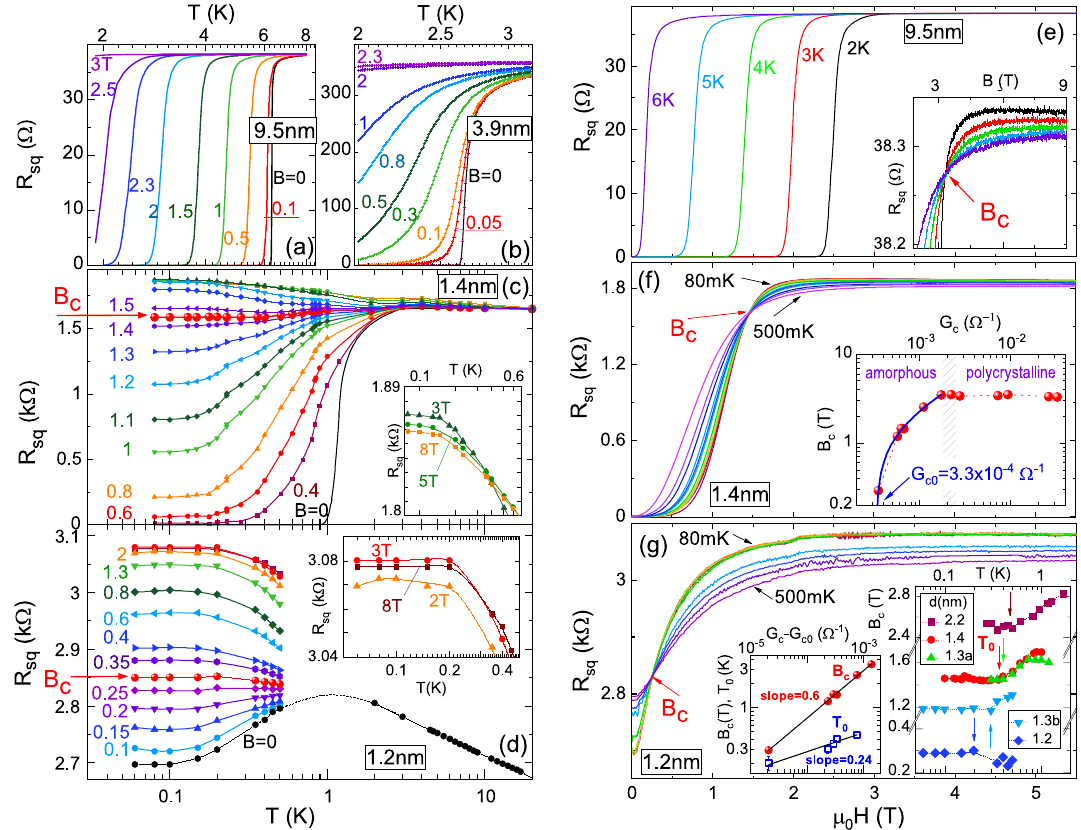
Figure 1. R sq versus T for various B as labeled near the curves (in teslas) ( a – d ), and R sq versus B at various T as labeled near the curves ( e – g ), for films with various d : ( a ) 9.5 nm, ( b ) 3.9 nm, ( c ) 1.4 nm, ( d ) 1.2 nm, ( e ) 9.5 nm, ( f ) 1.4 nm, ( g ) 1.2 nm. Red arrows indicate B c . Insets in ( c ) and ( d ): regions of negative MR on the expanded scale. Inset in ( e ): expanded region near B c . Inset in ( f ): B c versus G c (measured at the lowest T ). Blue curve shows the fit described in the text, B c = A ( G c − G c 0 ) p . Right inset in ( g ): B c versus T for several amorphous films. The arrows indicate T 0 , below which B c is constant. Left inset in ( g ): B c and T 0 versus G c − G c 0 on a double logarithmic scale. The lines have slopes of 0.6 and 0.24,